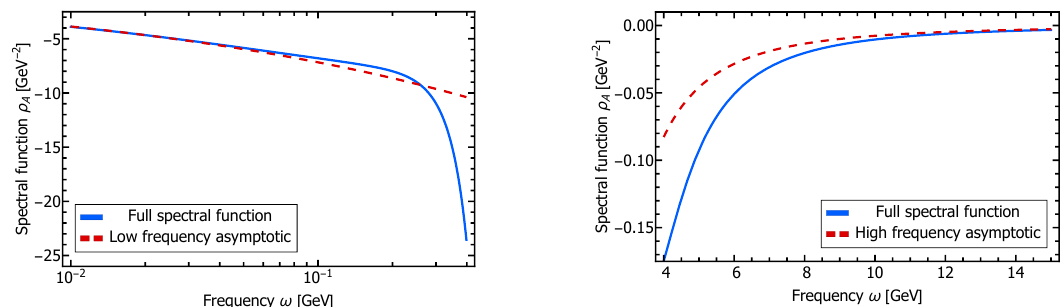
Figure 7: Low (left) and high (right) frequency behavior of our result for the spectral function shown in Figure 6. The dashed red lines show the asymptotic limits given by (23) and (16).